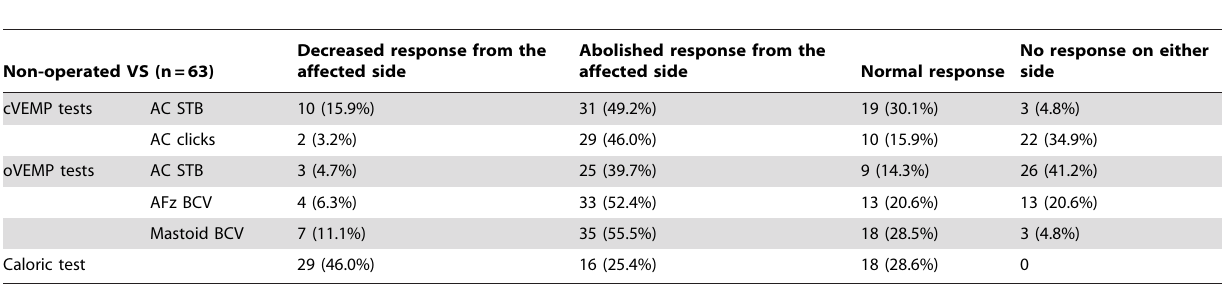
Table 3. Number (%) of non-operated VS patients (n=63) exhibiting abnormally weak (decreased or abolished) response from the affected side or normal responses to vestibular tests (ACS cVEMPs, AC STB and BCV oVEMPs, and caloric tests).